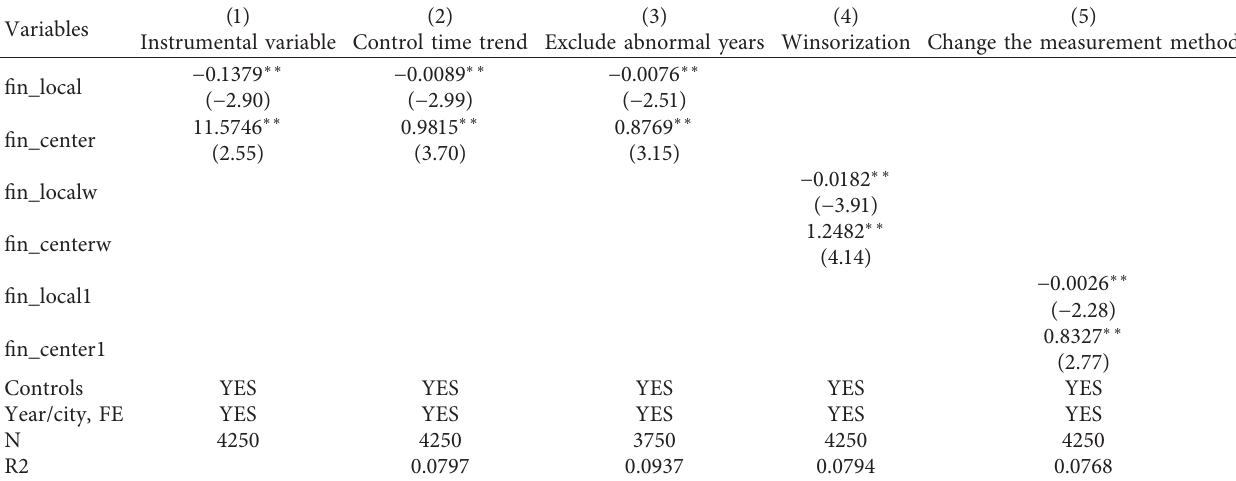
Table 4: Robustness test and endogenous treatment.